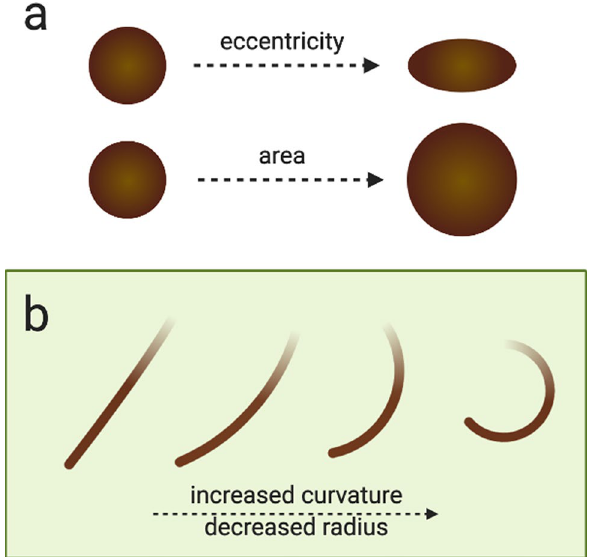
Figure 1. Quantifiable aspects of hair morphology. ( a ) Diagram of cross-sectional eccentricity and area. ( b ) Curvature is calculated as the inverse of the radius in mm ( radius with a decrease in the radius of the circle fitting the